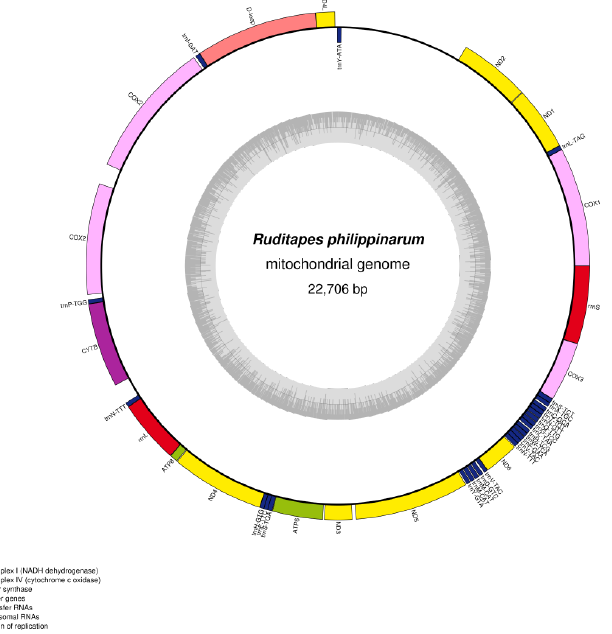
Figure 3. Circular genome map of Ruditapes philippinarum mitochondrial DNA. The transcription direction of the gene in the ring proceeds clockwise, while transcription of the gene outside the ring proceeds counterclockwise. Different functional genes are marked with different colors. The inner gray circle depicts GC content along the genome, and the gray line at the center denotes the 50% threshold.